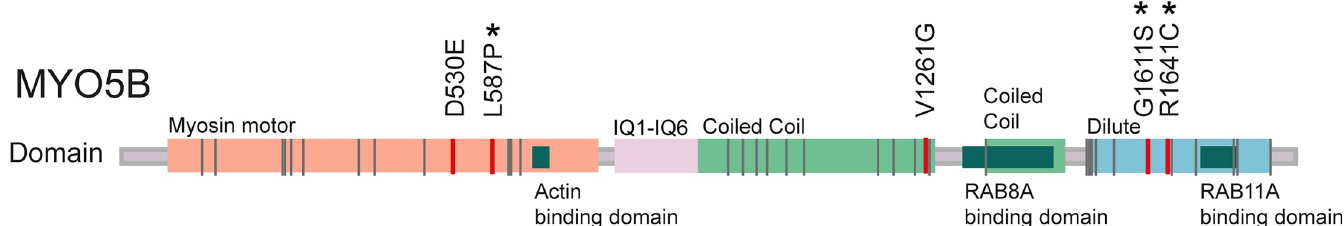
Fig 1. Localizations of mutations in MY05B . Schematic presentation of the MYO5B gene, located on chromosome 18, containing 40 exons encoding the MYO5B protein (NP_001073936, 1848 amino acids). MYO5B constitutes of a myosin head domain and a globular tail (dilute) domain. Protein domains and motifs are presented according to Qiu et al [76], and the RAB8A- and RAB11A-binding sites according to Roland et al [23]. Localization of the five missense mutations in MYO5B identified in Wilze´n et al [14] are marked in red, and the three selected mutations (p.L587P, p.G1611S, and p.R1641C) analyzed in the current study are marked with a star. Previously identified MYO5B mutations in colon cancer are according to Letellier et al [32] and marked in grey. IQ = IQ motif, BD = binding